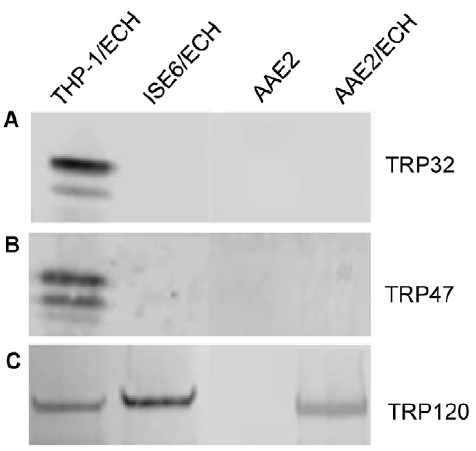
Figure 4. Expression of E.chaffeensis TRPs in human (THP-1) and tick (ISE6 and AAE2) cell lysates. Western immunoblots were probed with anti-TRP32 (A), anti-TRP47 (B) and anti-TRP120 (C) antibodies. TRP120 was detected in E. chaffeensis -infected human and tick cell lysates, and TRP32 and TRP47 were detected only in E. chaffeensis -infected THP-1 cells.